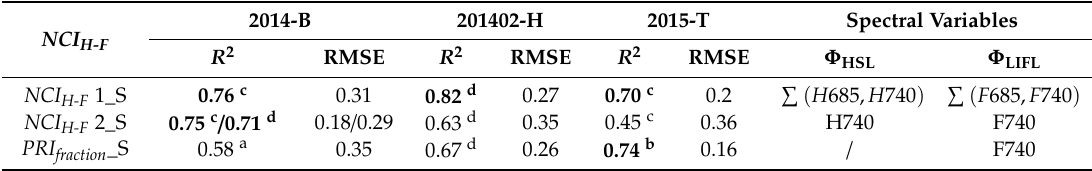
Table 2. GSI-based NCIH-F used for LNC estimation and its corresponding R 2 and RMSE for year of 2014 and 2015